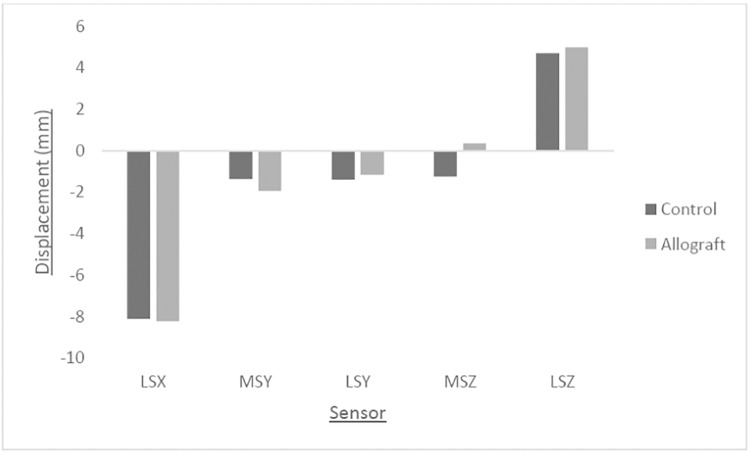
Mean displacement (mm) at each sensor position around the tibial head at specimen failure.Negative values at LSX indicate lateromedial movement. Negative values at MSY and LSY indicate posteroanterior movement. Negative and positive values at MSZ and LSZ indicate vertical upward and downward movements, respectively.